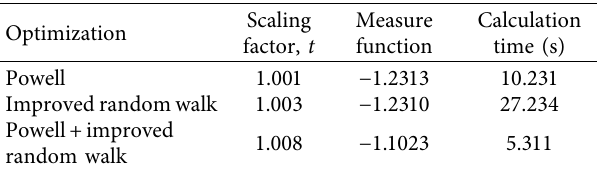
Table 7: The comparison of the relevant results of the optimization algorithms.